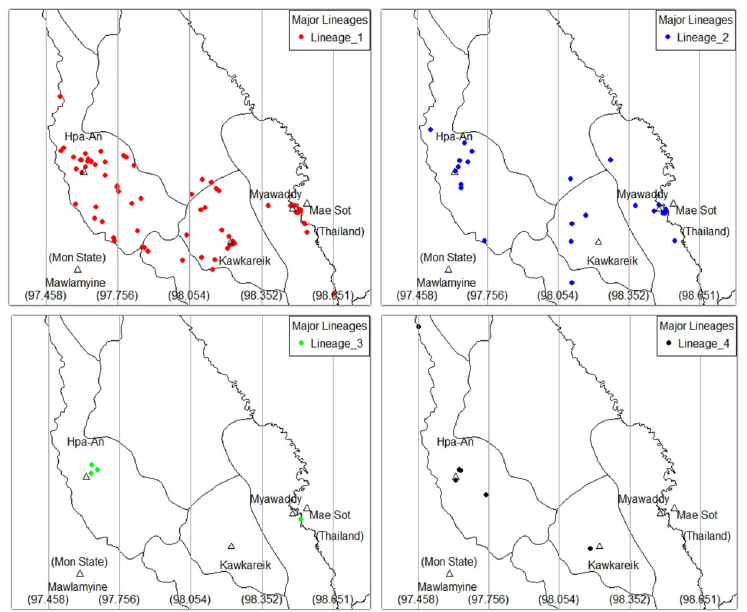
Figure 3 . Geographic distribution major lineages of Mycobacterium tuberculosis .